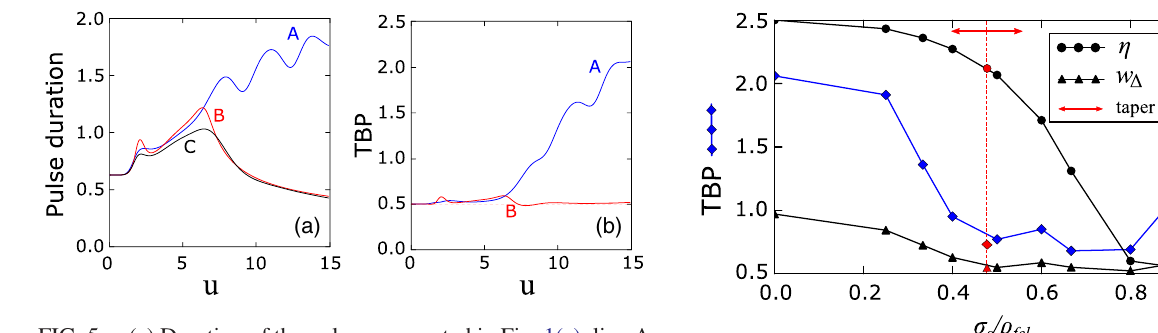
TABLE I. Parameters η , w Δ and TBP in the three conditions: no energy spread ( null ), optimum energy spread ( ρ energy spread according to Eq. (7) ( taper ), with α